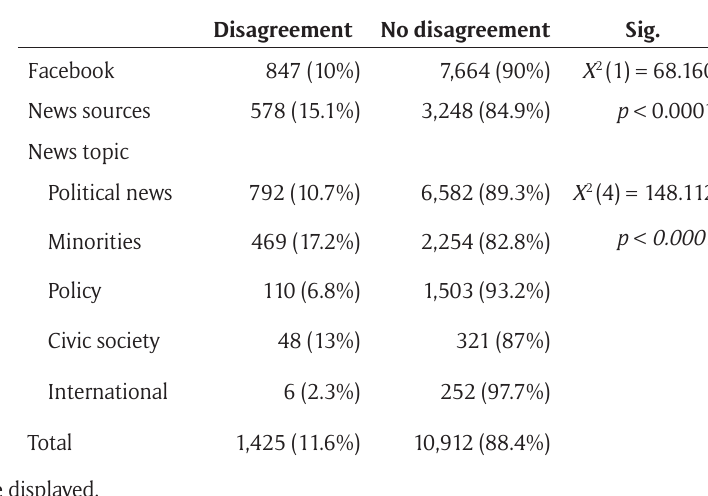
Table 1: Frequency of disagreement per platform and topic.